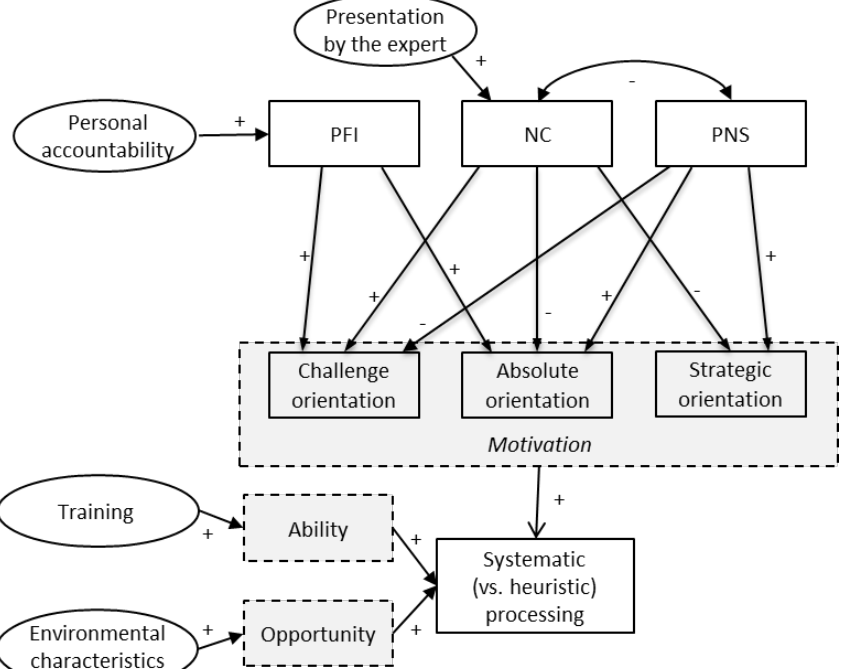
Figure 6. A conceptual framework of the hypothesised relationships between various solutions to enhance systematic